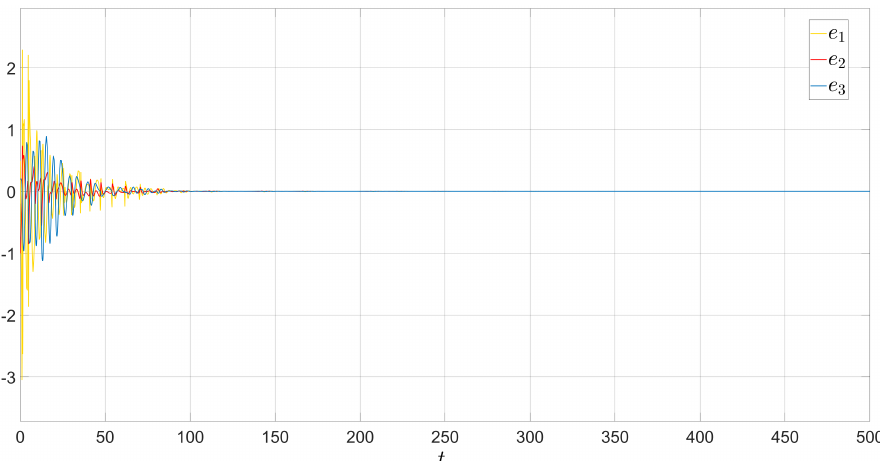
Figure 7. Identification process for irregular bursting regime, γ = 1.